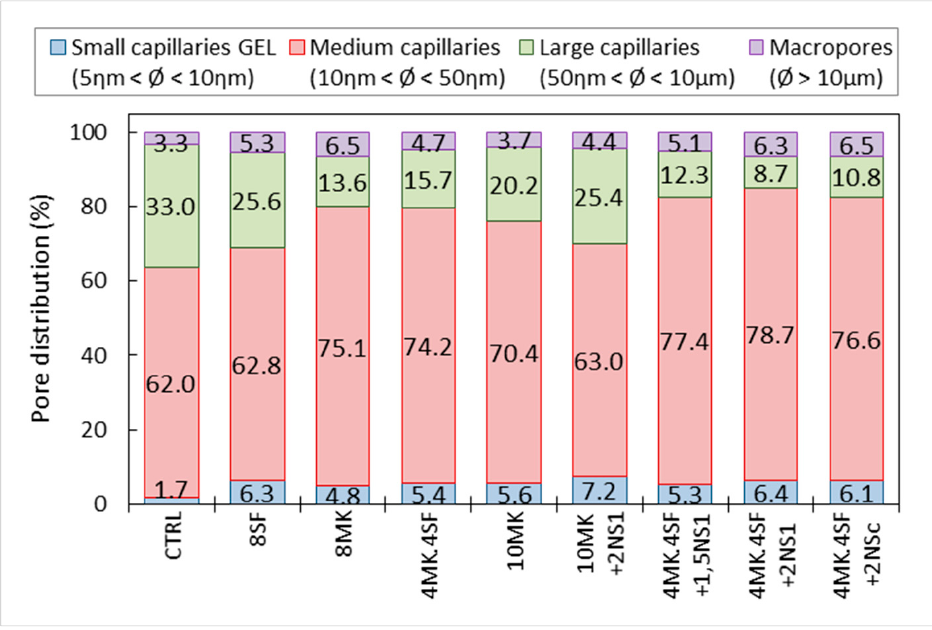
( b ) Figure 11. Influence of portlandite ( a ) and CSH gel ( b ) on compressive strength at 28 days.